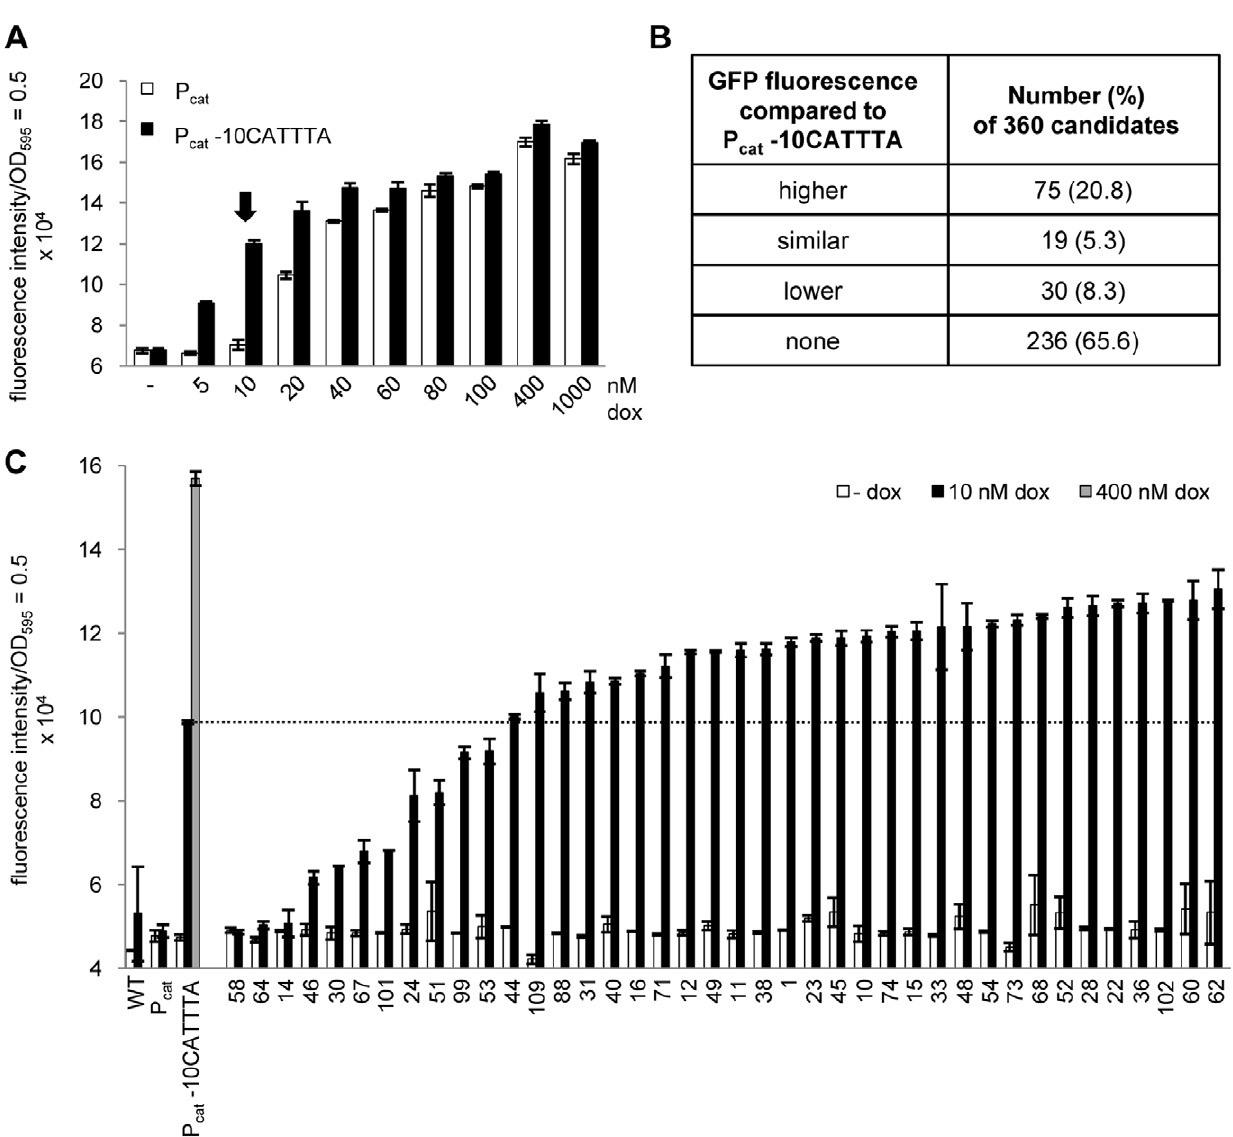
Figure 3. A synthetic promoter library generated by random mutagenesis of the P cat -10 element yields candidates with different induction efficiency. (A) Dose-response curve of P cat and P cat -10CATTTA strains to identify the dox concentration for screening (indicated by an arrow). Both strains were incubated with increasing amounts of dox, and their respective GFP fluorescence was determined in a microplate reader. (B) Classification of the 360 library candidates according to their GFP fluorescence with respect to the reference strain carrying P cat -10CATTTA. Total numbers are listed and percentages are given in brackets. (C) GFP fluorescence measurement of 40 promoter library candidates, ordered by increasing fluorescence. Controls were Salmonella WT and the strains containing P tetA gfp + either with P cat tetR or with P cat -10CATTTA tetR . Candidates and controls were incubated without and with 10 nM dox. For maximum induction of TetR, the P cat -10CATTTA strain was incubated with 400 nM dox. The dashed line allows a direct comparison with the induction level of the P cat -10CATTTA strain at 10 nM dox. Bars in (A) and (C) represent the fluorescence intensity which was normalized to a 1 ml culture with OD 595 =0.5. The data are a representative set from at least three independent measurements and display the mean 6 standard